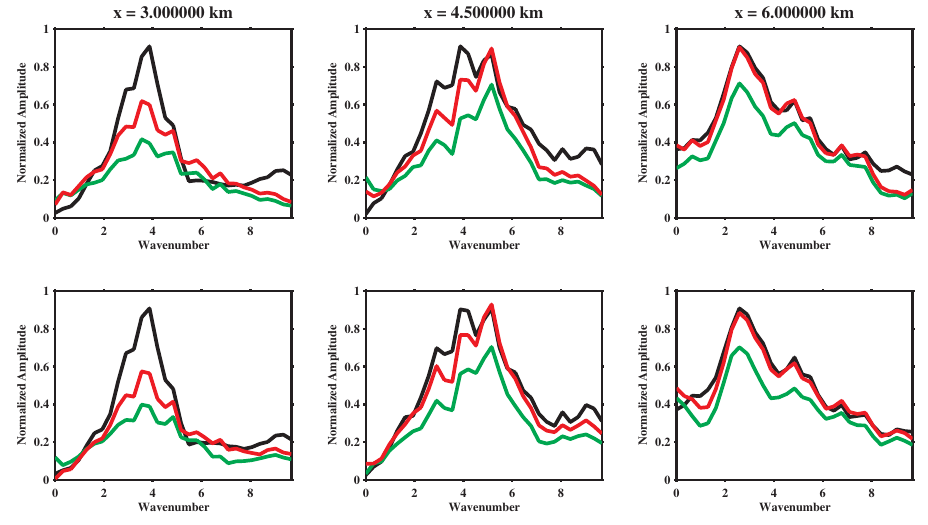
Figure 21. The 1D wavenumber spectrum of vertical profiles, corresponding to Figure 20. Black lines denote the true model, red lines indicate the results using 4C data, and green lines are the ones using 1C